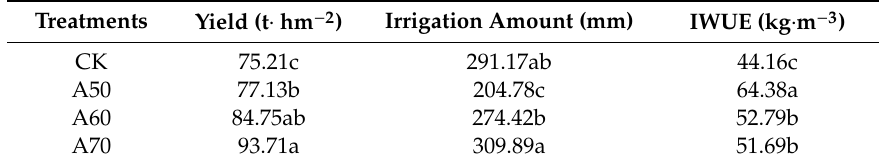
Table 4. Yield, irrigation amount, and irrigation water use e ffi ciency (IWUE) under